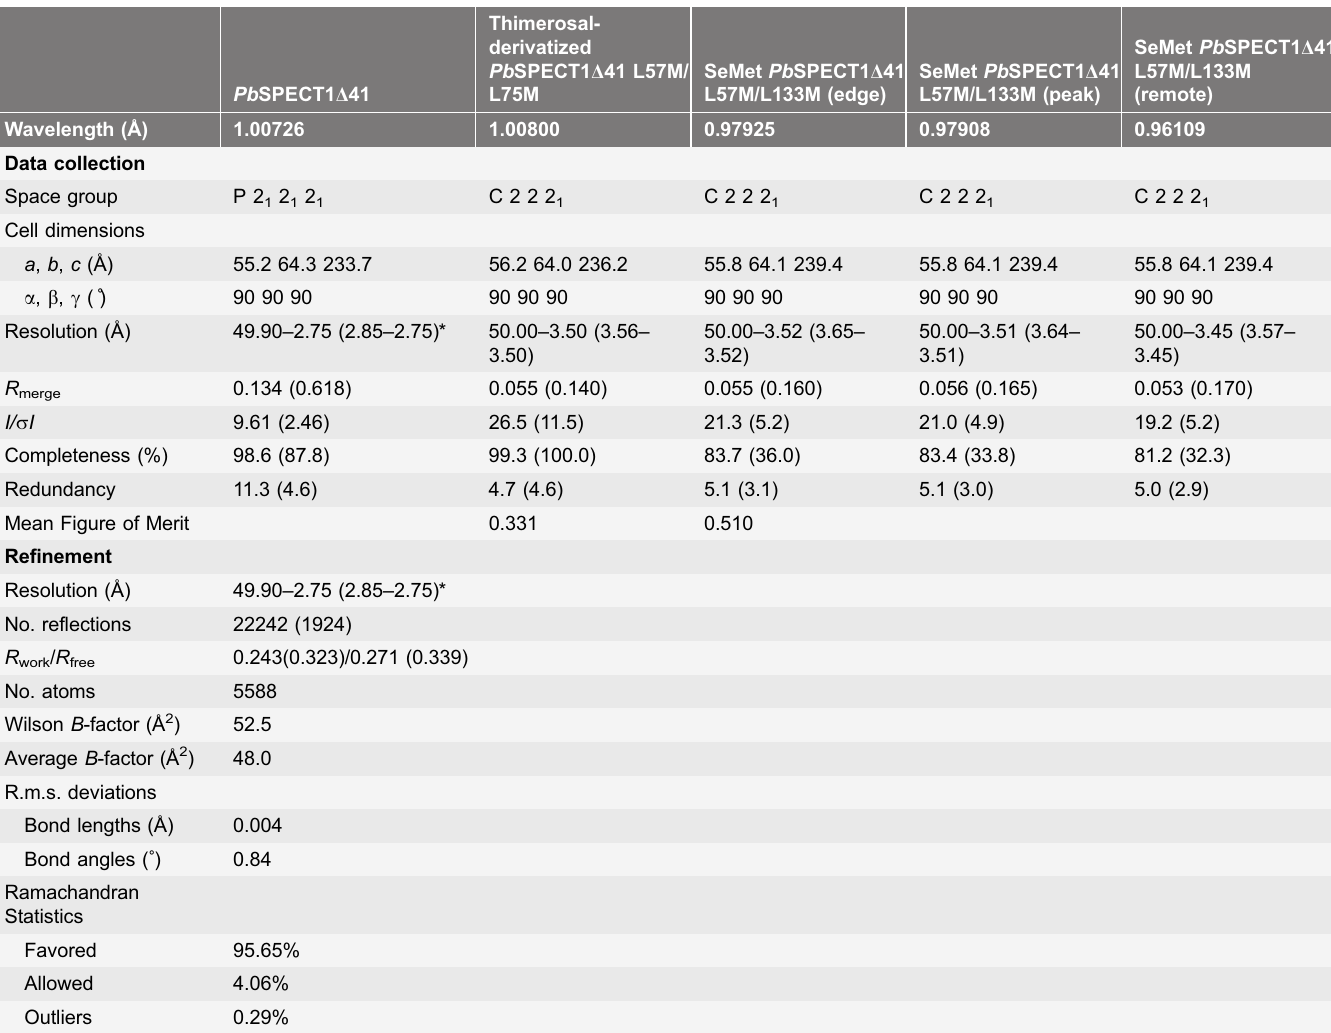
Table 1. Crystallographic Data Collection and